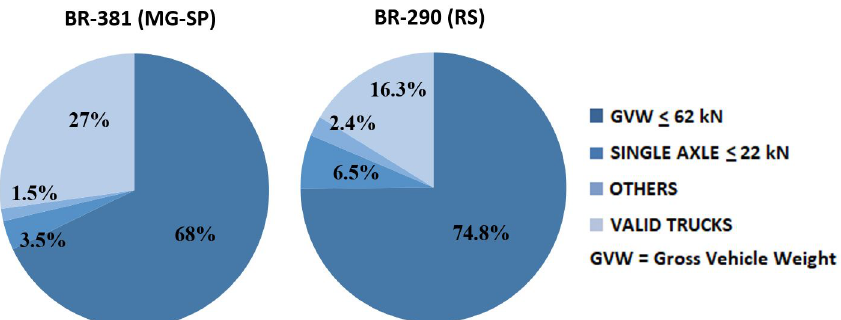
Figure 8. Statistics of filtered data (adapted from Portela [15]).